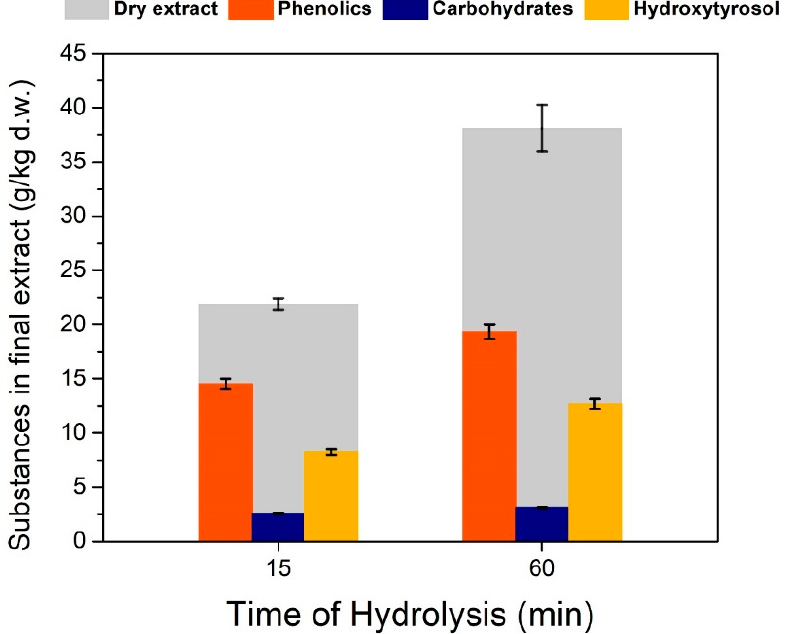
Figure 11. Effect of time of hydrolysis, on the substance profile in the final extract. Solid–liquid extraction was performed at 40 ◦ C, hydrolysis was performed with H 2 SO 4 at pH 1 and boiling under reflux for 15 min.